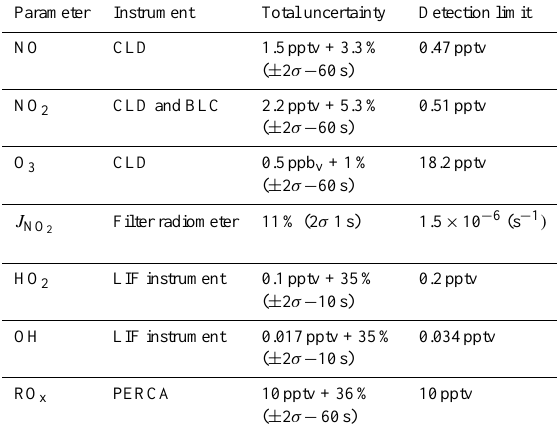
Fig. 4. Leighton ratio calculated from observations in the unpol- luted MBL, in moderately polluted air near South Africa, and in the pollution plume of a passing ship. The color coding indicates the NO 2 photodissociation frequency (which scales with light inten- sity). We estimate the 2 σ uncertainty in ϕ at approximately 93%, 71%, 63% and 11% for NO 2 mixing ratios of 3, 5, 10 and 100pptv,